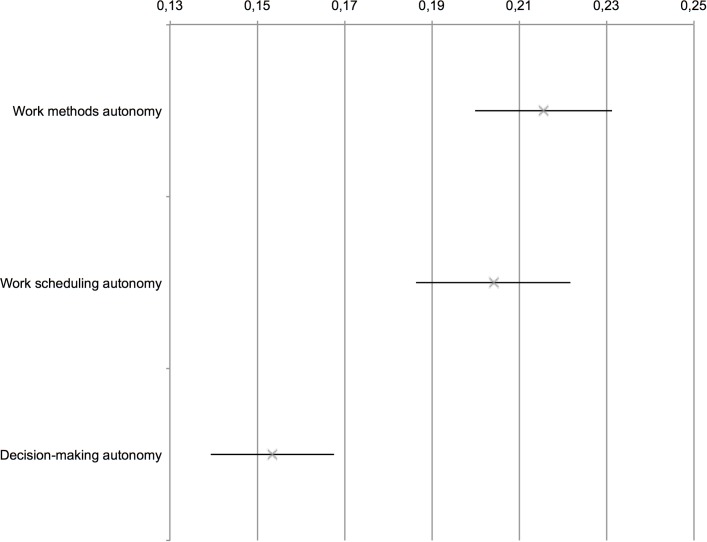
Z-standardized coefficients of autonomy attributes including 95% confidence intervals.Note: 95% confidence intervals centered around z-standardized HLM coefficients of the cross-level interactions model presented in Table 4.